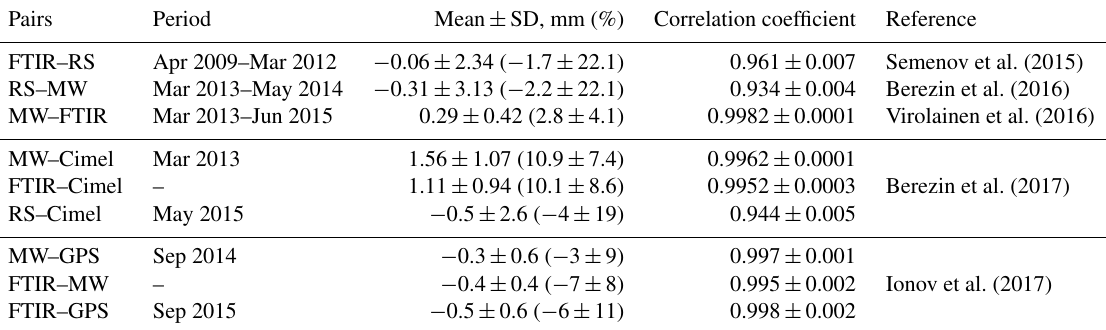
Table 1. The IWV comparison campaigns at the St. Petersburg site, involving the data of FTIR, GPS, Cimel sun photometer, and radiosonde (RS) measurements. Mean is the mean difference; SD is the standard deviation of mean difference.